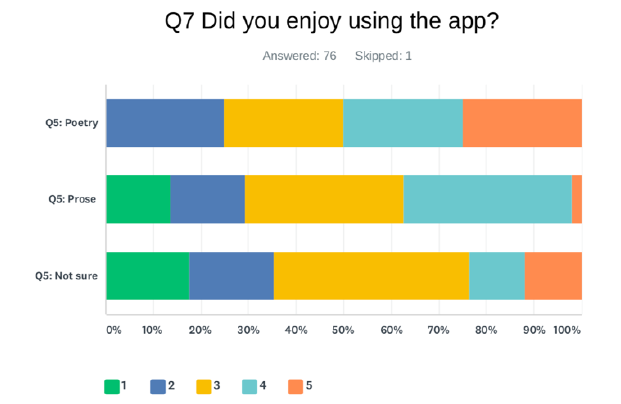
Figure 6. Question 7 split by scores to “Q5. Which do you prefer, poetry or prose?”